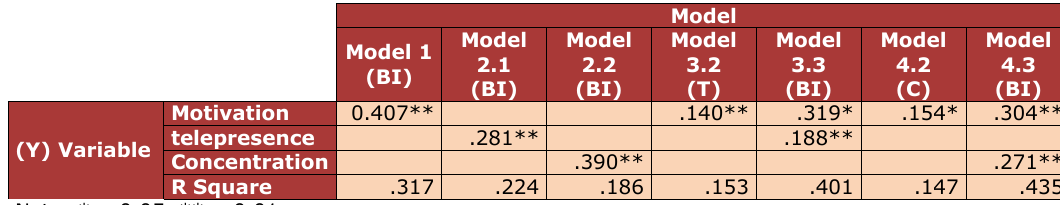
Table 3. mediation effect of telepresence and